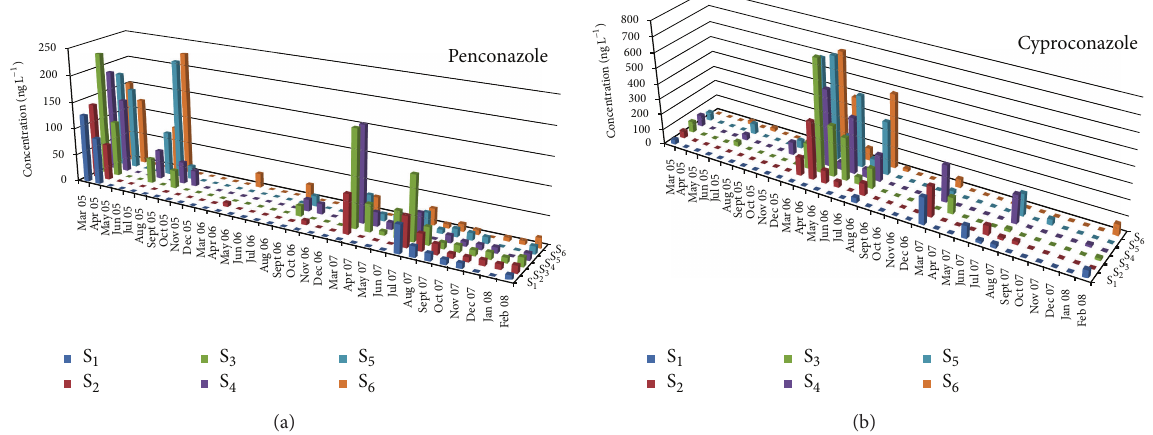
Figure4:Temporalandspatialdistributionofselectedfungicide(penconazole(a)andcyproconazole(b))concentrationsduringthesampling period (March 2005–February 2008) for the six sampling